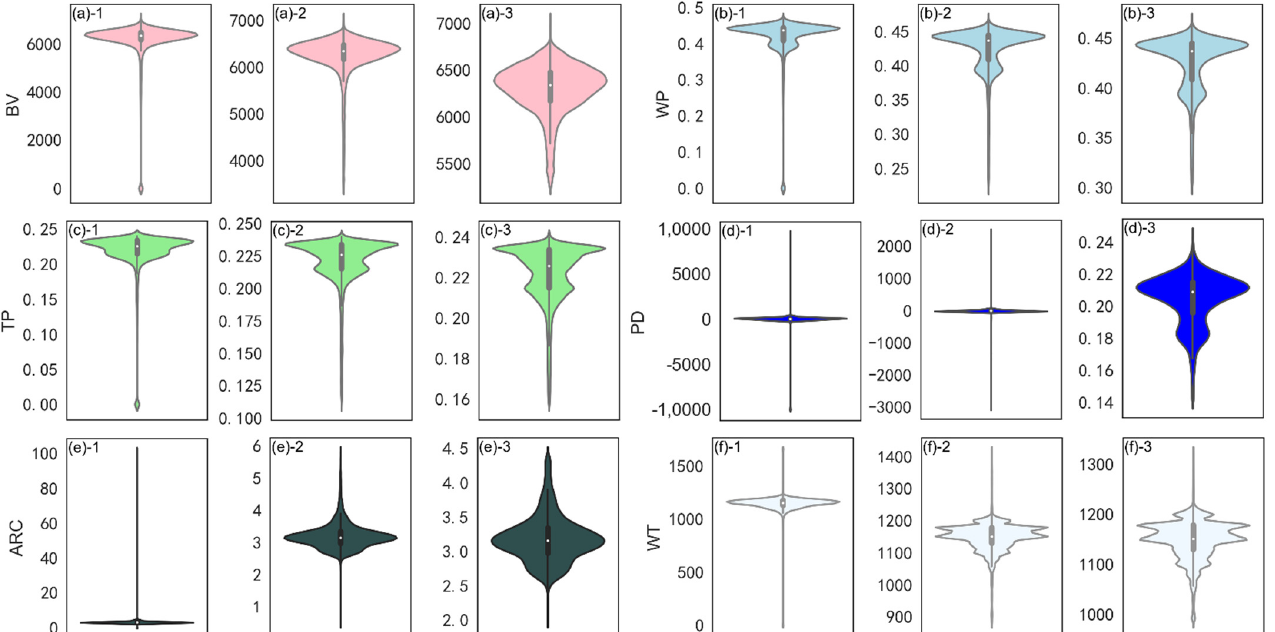
Figure 2. ( a – f ) Comparison of original data and processed data (2), i (i = 1, 2, 3,) represents the data before a feature is processed, after it is processed by the box plot, and after it is processed by the 3 σ criterion, respectively.